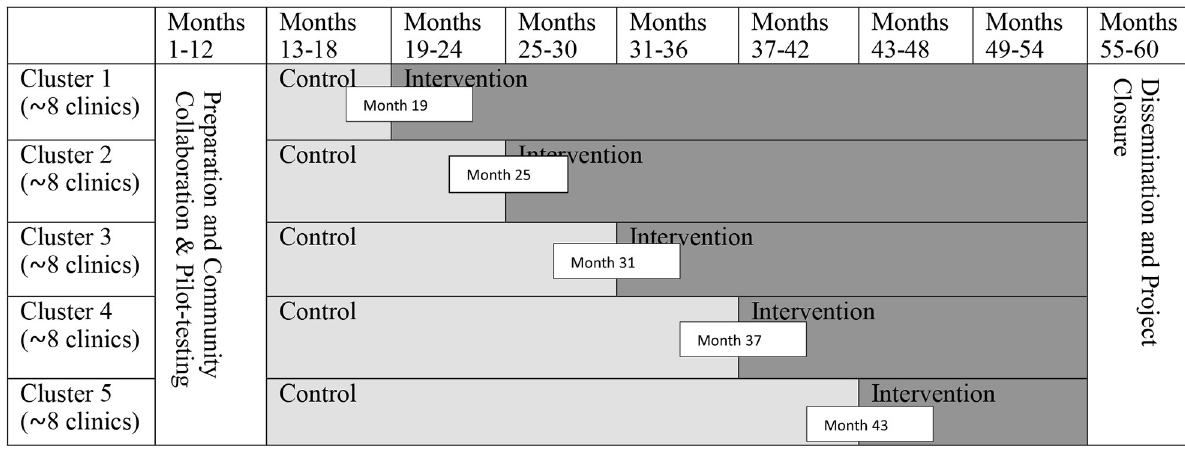
TABLE 1 | Stepped wedge cluster randomized trial